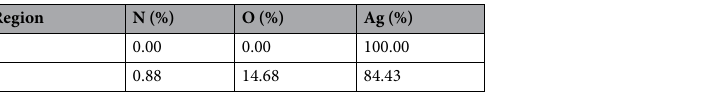
Table 1. Atomic ratios measured by using energy dispersive X-ray spectroscopy on regions 1 and